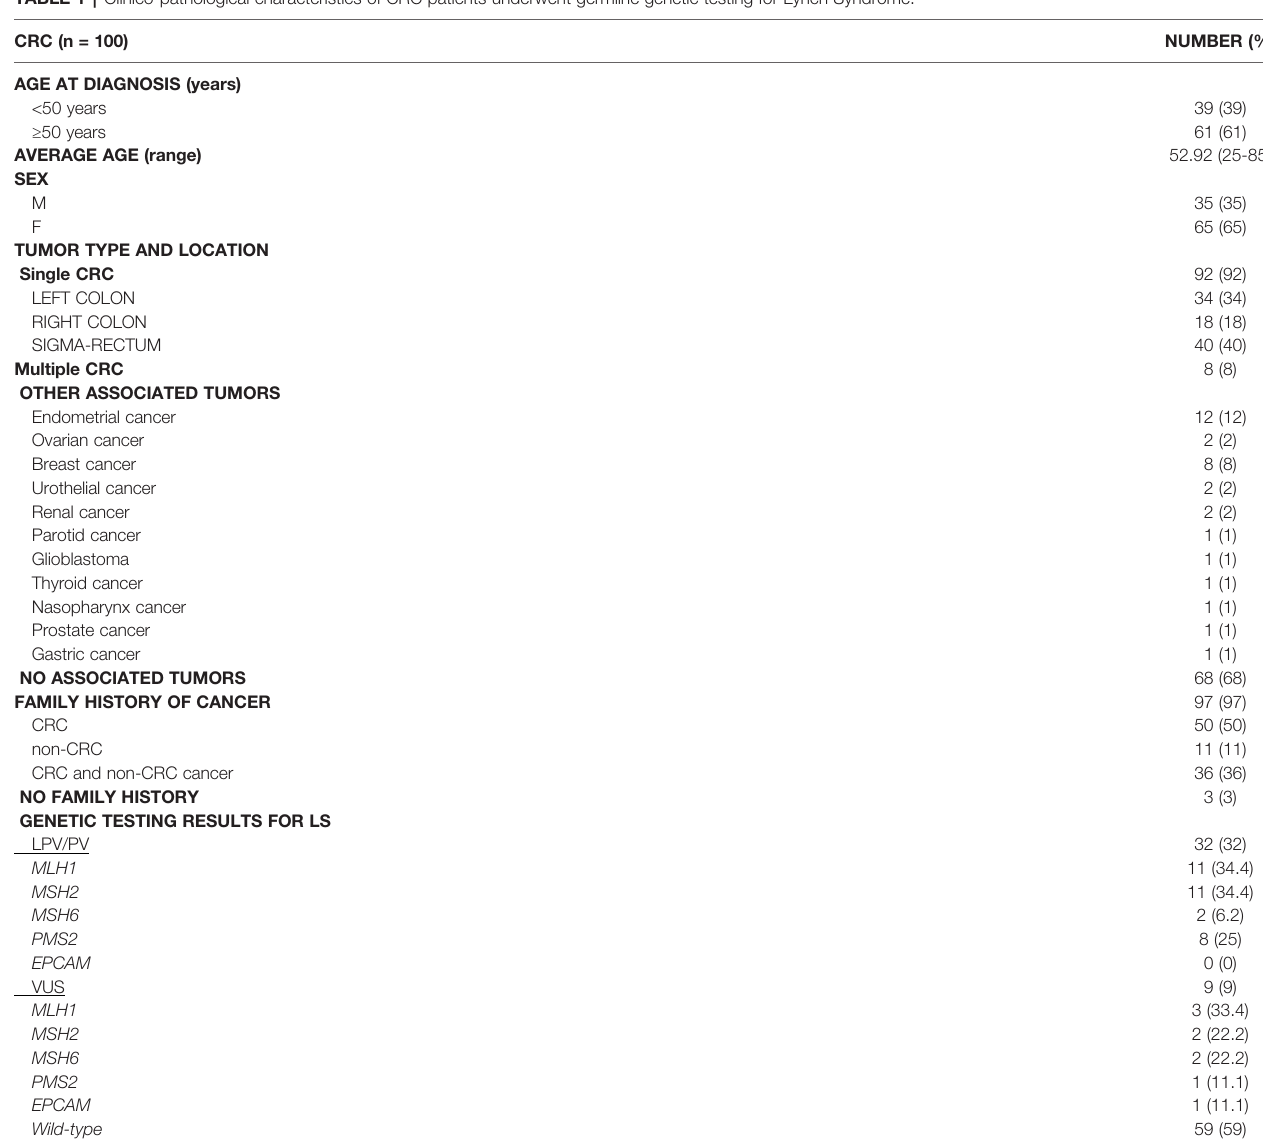
TABLE 1 | Clinico-pathological characteristics of CRC patients underwent germline genetic testing for Lynch